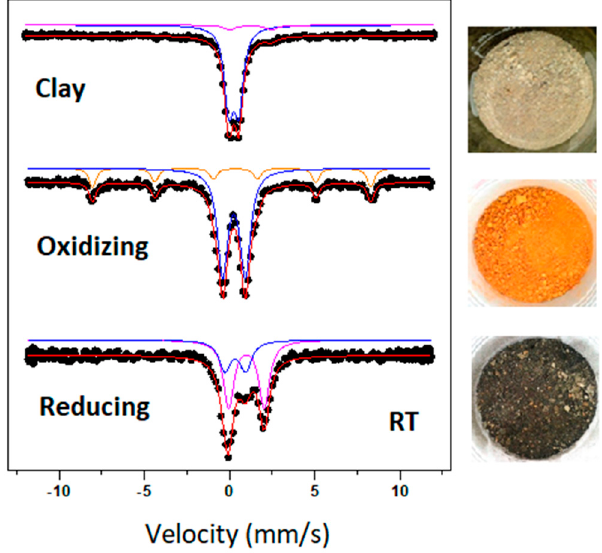
Figure 4. Oxidizing and reducing firing environments Mössbauer spectra at 800 °C for 12 h. The blue and pink spectra represent the quadrupole doublets of Fe 3+ and Fe 2+ , respectively. The orange spectrum represents the magnetic sextet of the hematite. The red spectrum is the magnetic components superposition present in the sample.